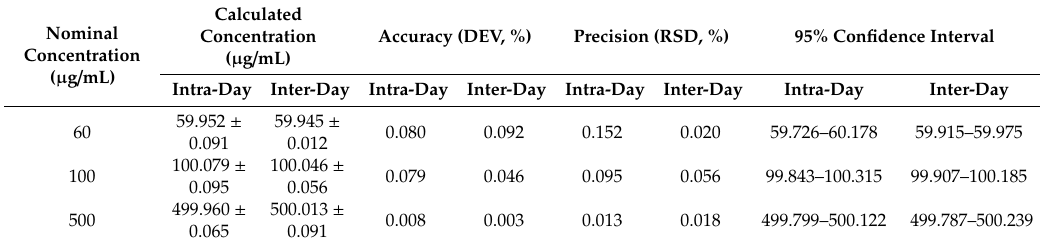
Table 2. Intra-day and inter-day accuracy and precision of theasaponin E 1 at three concentrations. Nominal Concentration